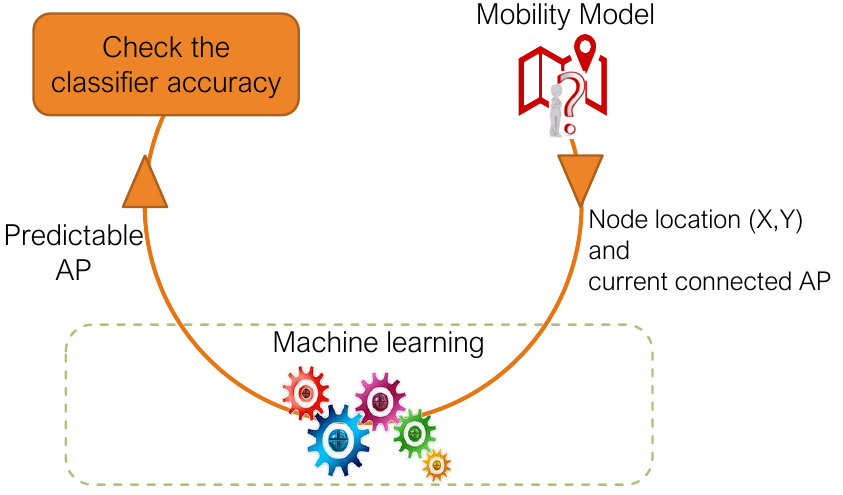
Figure 2. The method used in our